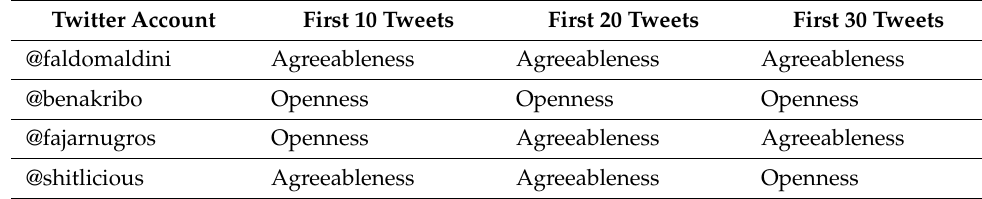
Table 6. Personality measurement